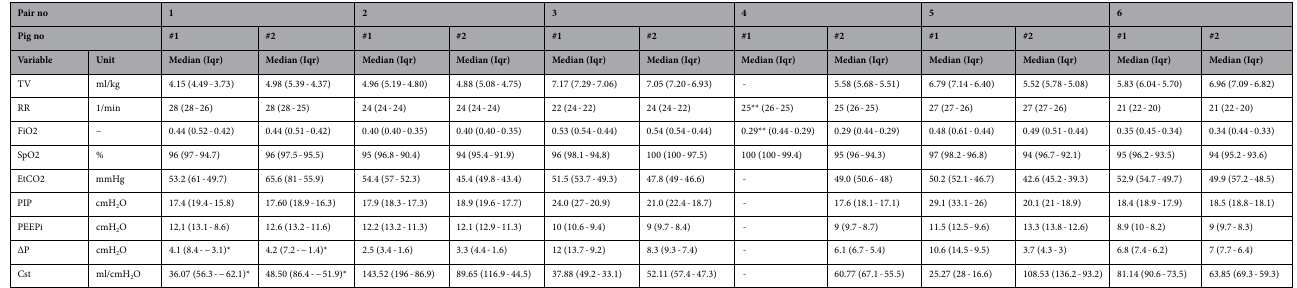
Table 2. Animal experiments results. Median and interquartile range values of selected ventilatory parameters for the ventilated pairs. TV, Tidal volume; RR, Respiratory rate; FiO 2 , Oxygen fraction in the inhaled gas; SpO 2 , Arterial blood saturation; EtCO 2 , End-tidal carbon dioxide; PIP Peak inspiratory pressure; PEEPi, Intrinsic positive end-expiratory pressure; ΔP, Driving pressure; Cst, Static lung compliance; IQR, Interquartile range. *The negative driving pressure and static compliance are due to highly noisy signals for pair no. 1. **Because the spirometric variables were not collected for object #1, the median and IQR values of FiO 2 and RR were copied from the object #2, as the two objects had these values in